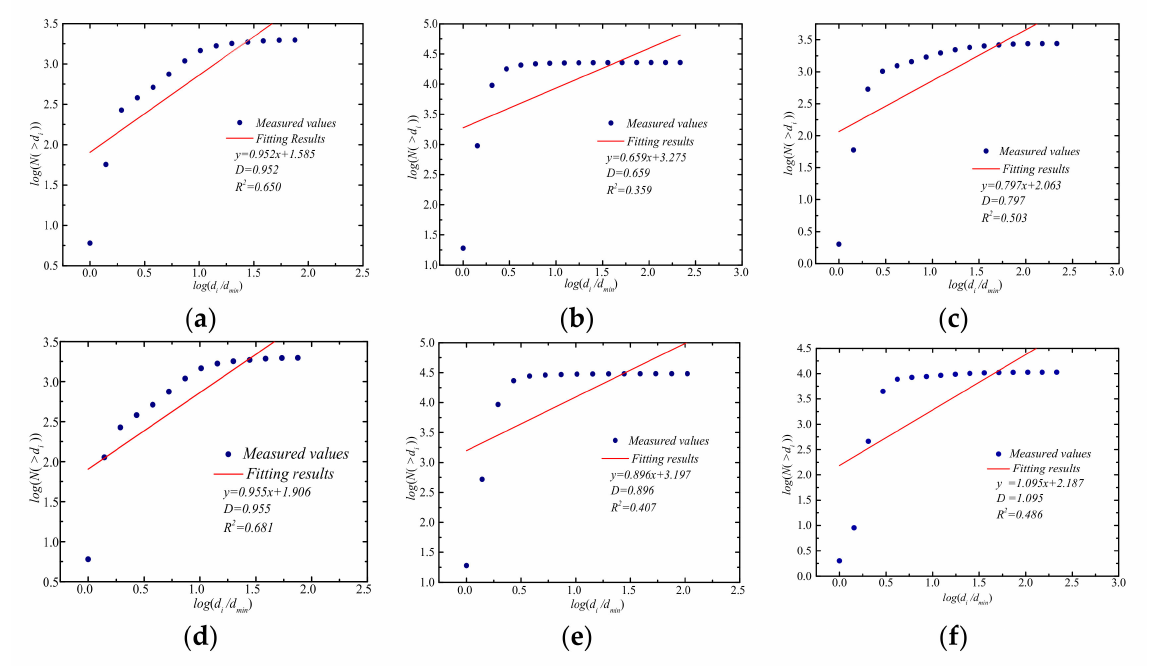
Figure 5. Fractal dimension of the number of mineral particles in undisturbed loess and lime-treated loess. ( a ) Quartz miner- als in undisturbed loess; ( b ) carbonate minerals in undisturbed loess; ( c ) feldspar minerals in undisturbed loess; ( d ) quartz minerals in lime-treated loess; ( e ) carbonate minerals in lime-treated loess; ( f ) feldspar minerals in lime-treated